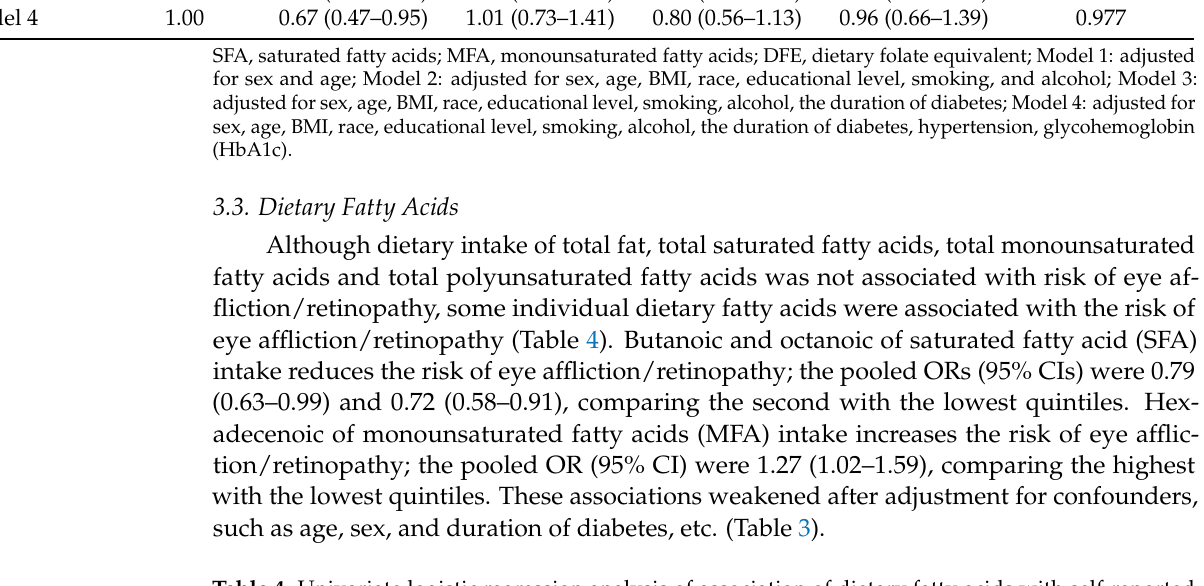
Table 4. Univariate logistic regression analysis of association of dietary fatty acids with self-reported eye affliction/retinopathy in individuals with